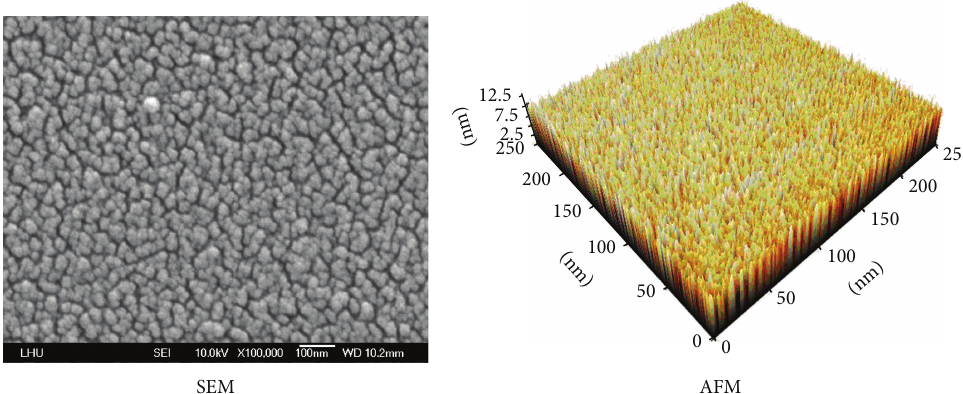
Figure 6: The SEM and AFM images for sample number